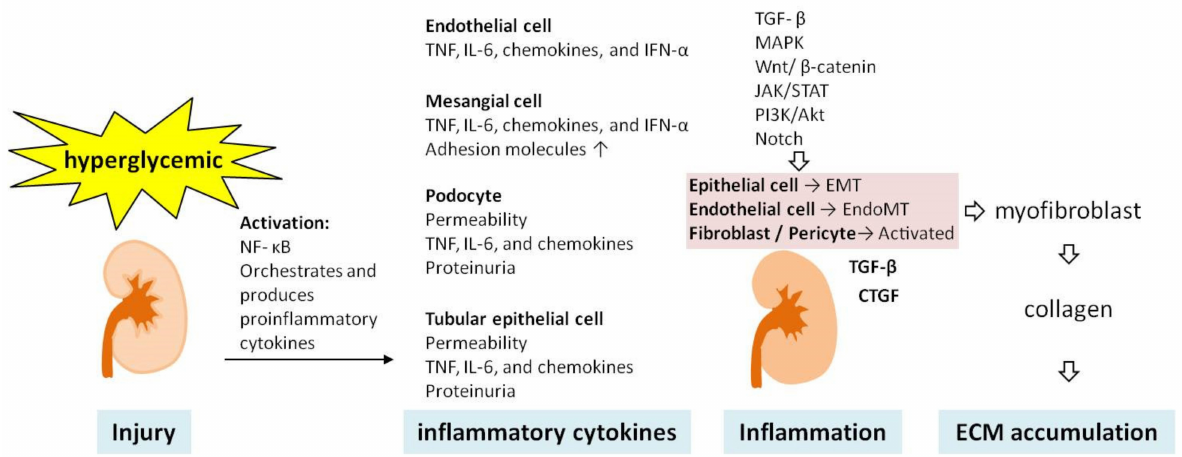
Figure 4. Mechanisms driving renal inflammation and fibrosis. ECM: extracellular matrix; EMT: epithelial–mesenchymal transition; EndoMT: endothelial–mesenchymal transition; IFN- α : interferon alpha; IL-6, interleukin 6; JAK/STAT: Janus kinase signal transducers and activators of transcription; MAPK: mitogen-activated protein kinase; TGF- β : transforming growth factor-beta; TNF, tumor necrosis